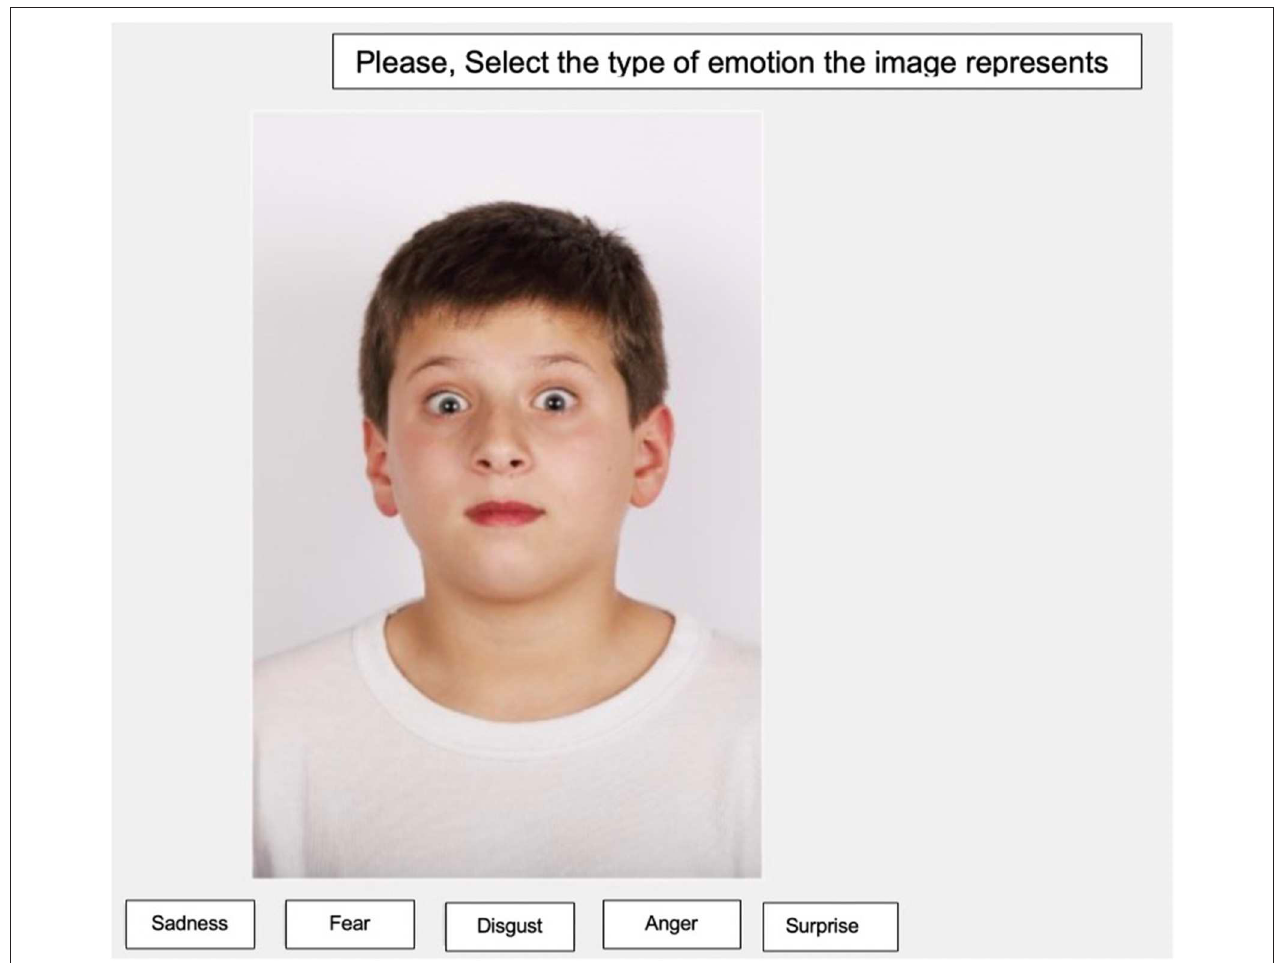
FIGURE 1 | Practice reqactive (“surprise of moderate intensity” in the male